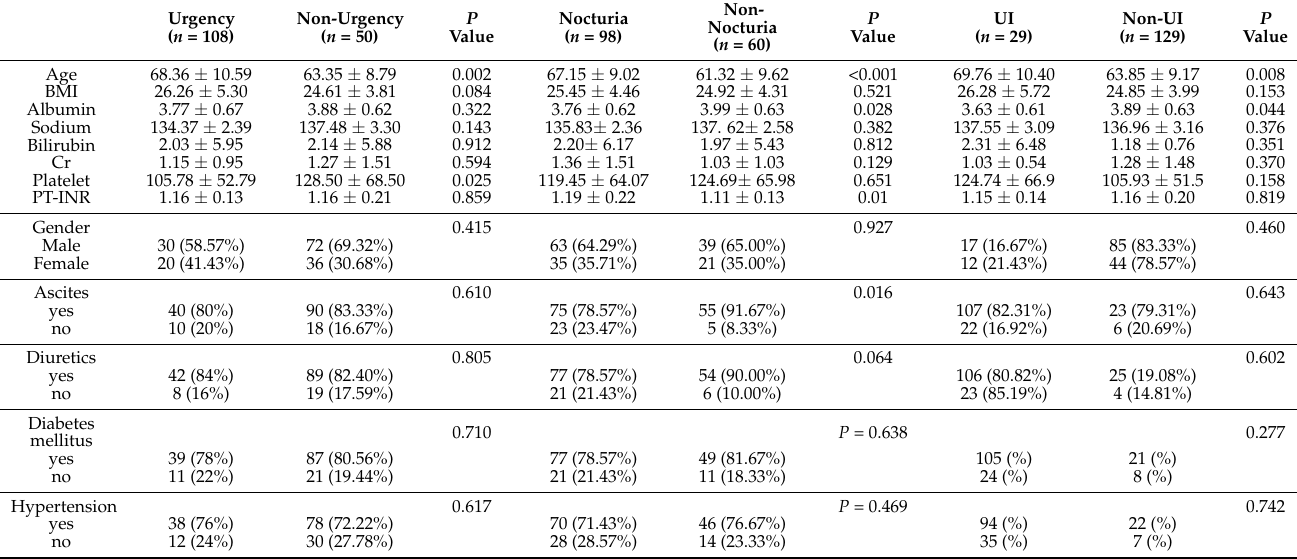
Table 3. Risk factors for urgency, nocturia and urge incontinence in the patients with liver